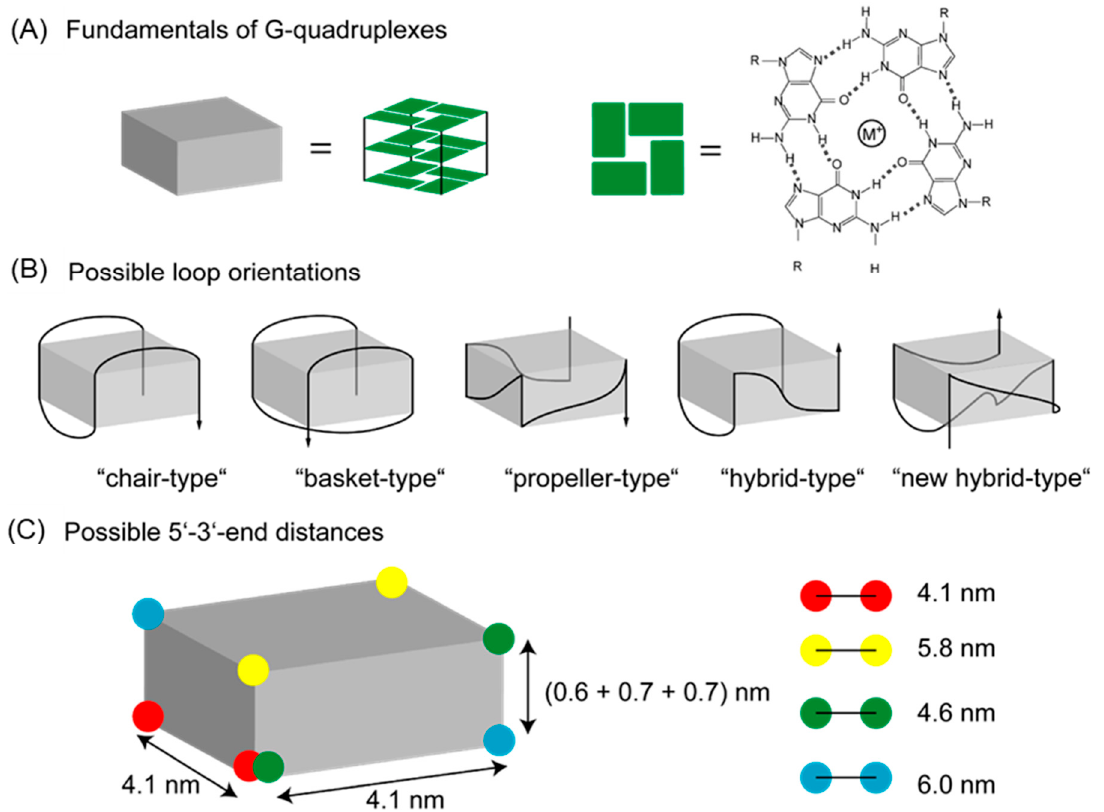
Scheme 1. Structural basics of G-quadruplexes. ( A ) G-quadruplexes are stacked G-tetrads which are four-associated guanine bases stabilized by hydrogen bonds and a cation in the middle. ( B ) The